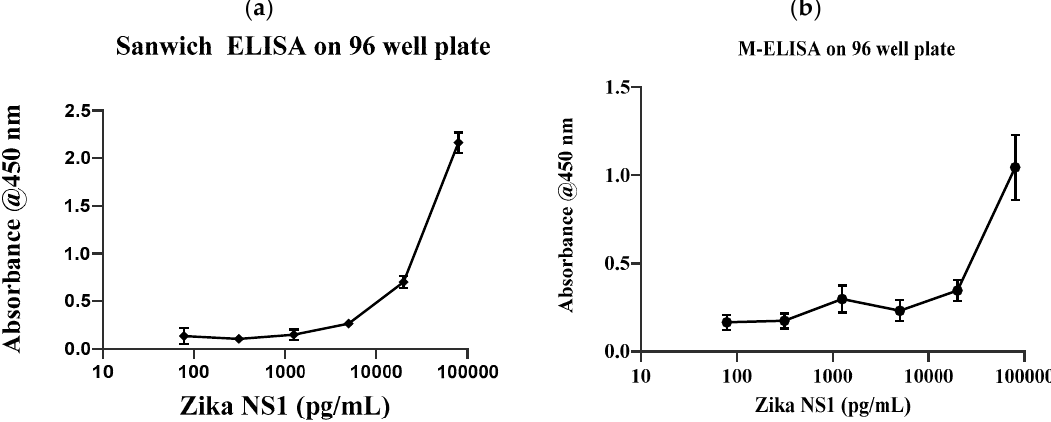
Figure 2. ( a ) Sandwich ELISA assay results using the recombinant Zika nonstructural protein 1 (NS1) antigen spiked on PBS buffer on 96-well plate as the Zika NS1 monoclonal antibody is used as a capture agent. Anti-Zika NS1 monoclonal antibody-HRP with a dilution factor of 1:1000 utilized to react with TMB calorigenic substrate to develop color. ( b ) M-ELISA assay on a 96-well plate showing spiking recombinant Zika NS1 on whole plasma. A 1:500 dilution factor of HRP-labeled anti-Zika NS1 was used and reacted with TMB to generate color. In both cases, color development was stopped by using H 2 SO 4 and absorbance was measured at 450 nm using a SpectraMax Gemini™ XPS/EM Microplate Reader (Molecular Devices, USA). Error bars are ±SD.